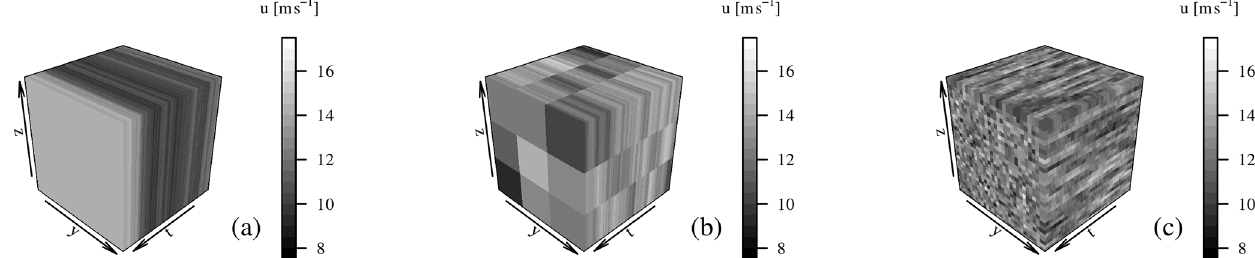
Figure 6. Exemplary visualization of the flow field excerpts for a mean velocity in the main flow direction of u = 12 . 5ms − 1 : (a) Gaussian type, fully correlated in space; (b) Gaussian type, 3 × 3 subdivision in space; (c) Gaussian type, delta correlated in